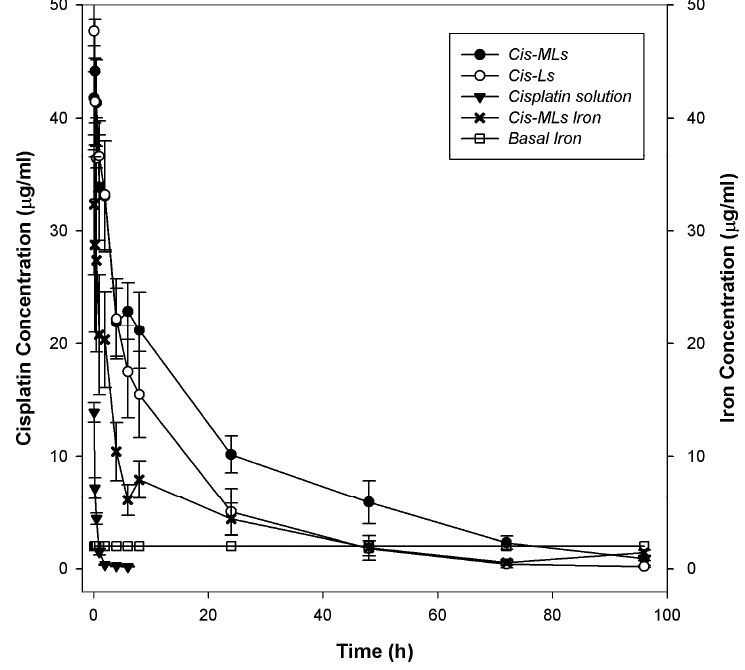
Figure 6. Cisplatin plasma concentrations versus time curves in rats subsequent to intravenous (i.v.) administration of cisplatin solution, cisplatin-loaded liposomes (Cis-Ls), or cisplatin magnetic liposomes (Cis-MLs). Iron plasma concentration versus time curve after i.v. administration of Cis-MLs. The dose injected corresponds to 6 mg/kg cisplatin and 2 mg/kg iron. Values are expressed as the mean ± SEM ( n = 5–6). Table 2. Pharmacokinetic parameters of cisplatin after i.v. administration of cisplatin solution, cisplatin liposomes, and Cis-MLs ( n = 5–6).